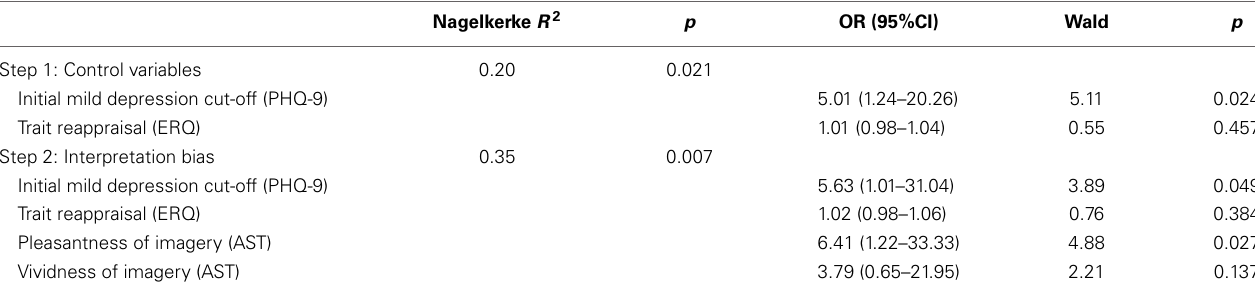
Table 3 | Positive interpretation bias prospectively predicts depression cut off during internship beyond initial depression and trait reappraisal. Nagelkerke R